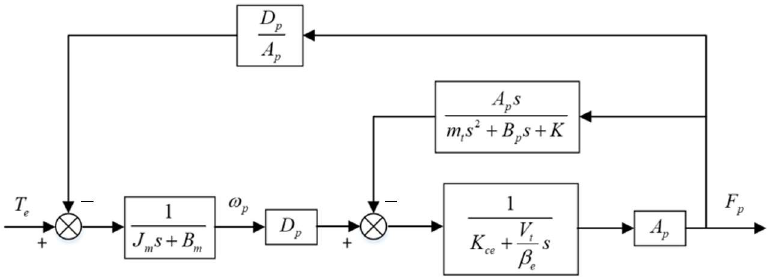
Figure 14. Pressure loop simplified control diagram.